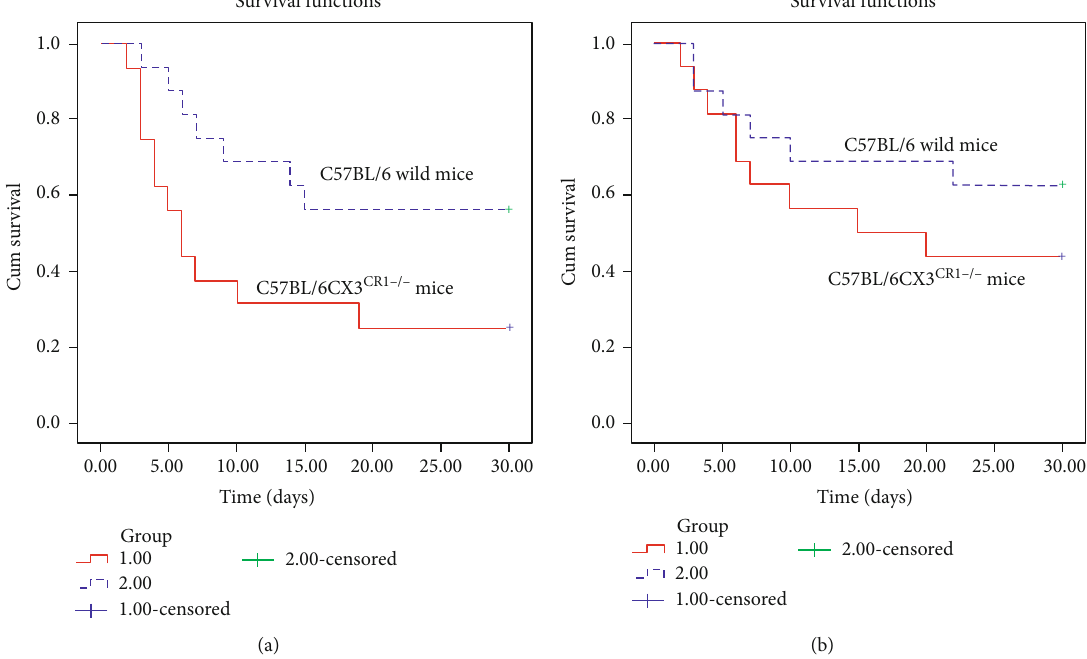
Figure 3: Univariate Kaplan-Meier analysis. (a) Survival functions of C57BL/6 CX3CR1-/- mice (red solid line) and C57BL/6 wild mice (blue dotted line) without MSC transplantation after AMI. (b) Survival functions of C57BL/6 CX3CR1-/- mice (red solid line) and C57BL/6 wild mice (blue dotted line) following MSC transplantation after AMI. Abbreviations: MSCs: mesenchymal stem